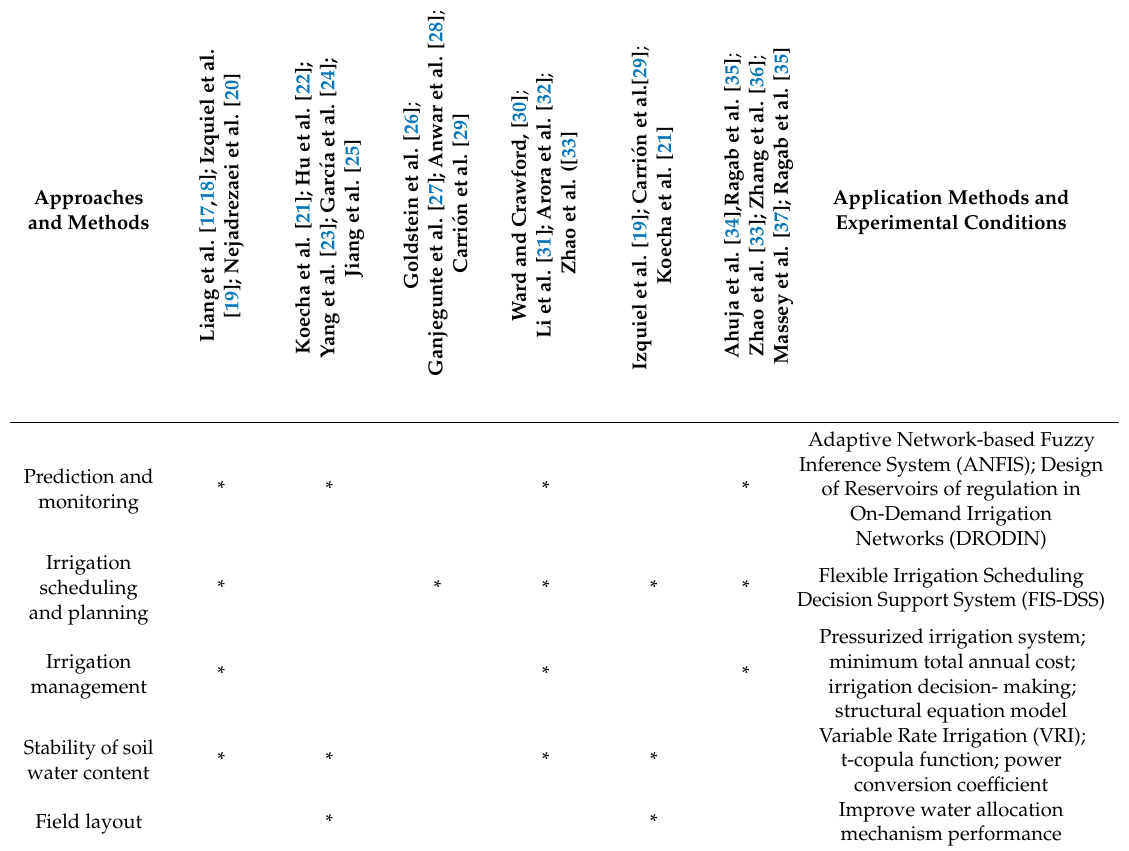
Table 1. Key influential factors for water allocation mechanism in precision